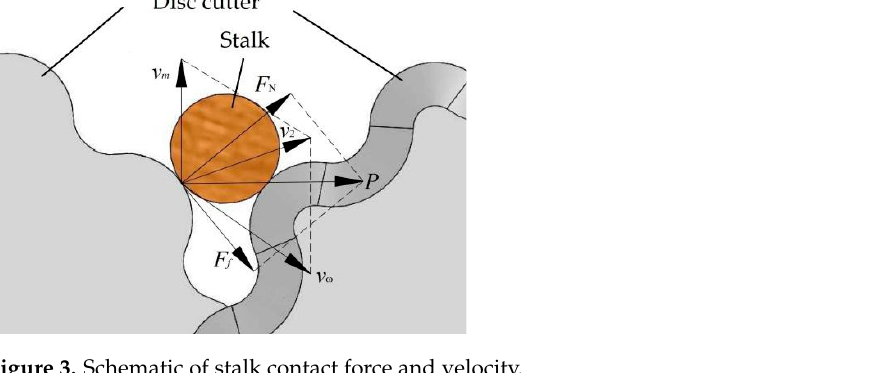
Figure 3. Schematic of stalk contact force and velocity.